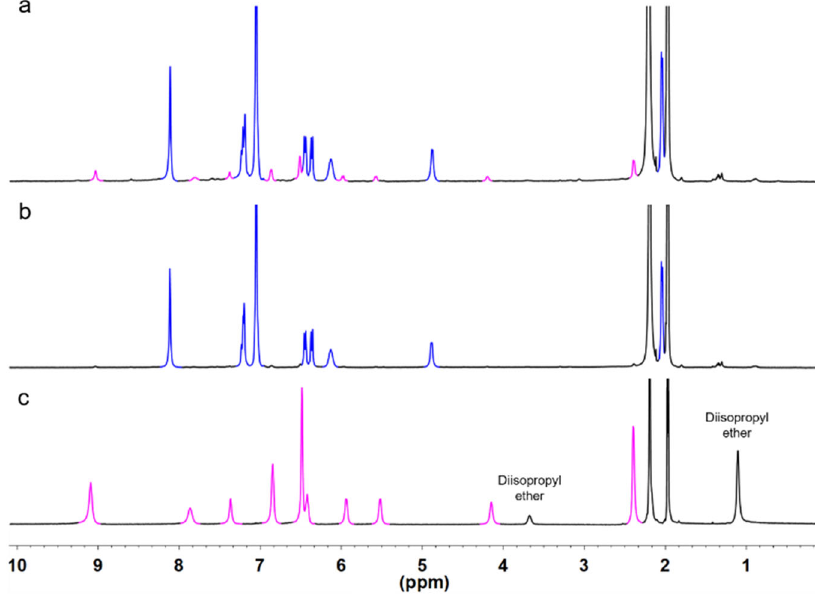
Fig. 4 1 H NMR of [Eu 2 L1 3 ]/[Eu 4 L1 6 ]. a 1 H NMR of crude mixture containing both of [Eu 2 L1 3 ] (blue) and [Eu 4 L1 6 ] (magenta) in a ratio of 96:4. b 1 H NMR showing pure [Eu 2 L1 3 ] by dissolving crude mixture after 3 days. c 1 H NMR of pure [Eu 4 L1 6 ] that was done simultaneously after dissolution of [Eu 4 L1 6